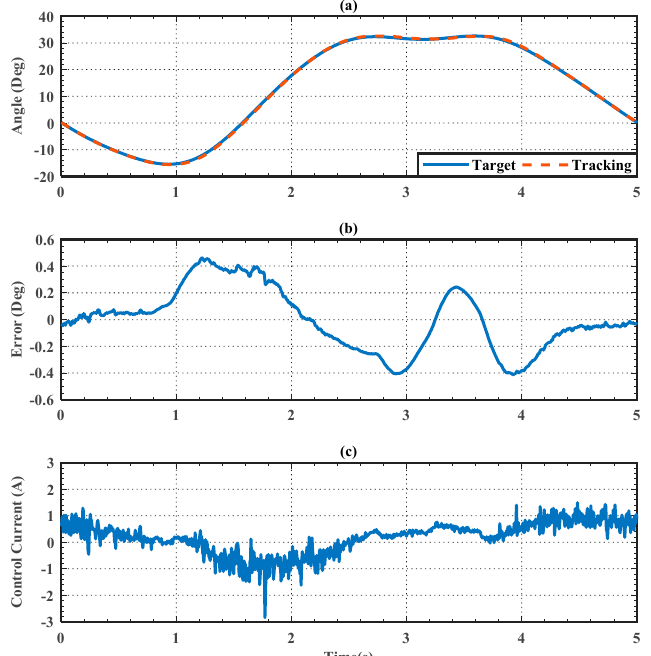
Figure 13. Right hip joint trajectory tracking for LES with the ILESO − PSMC. ( a ) Hip joint angle tracking response; ( b ) hip joint angle tracking error; ( c ) current control signal.